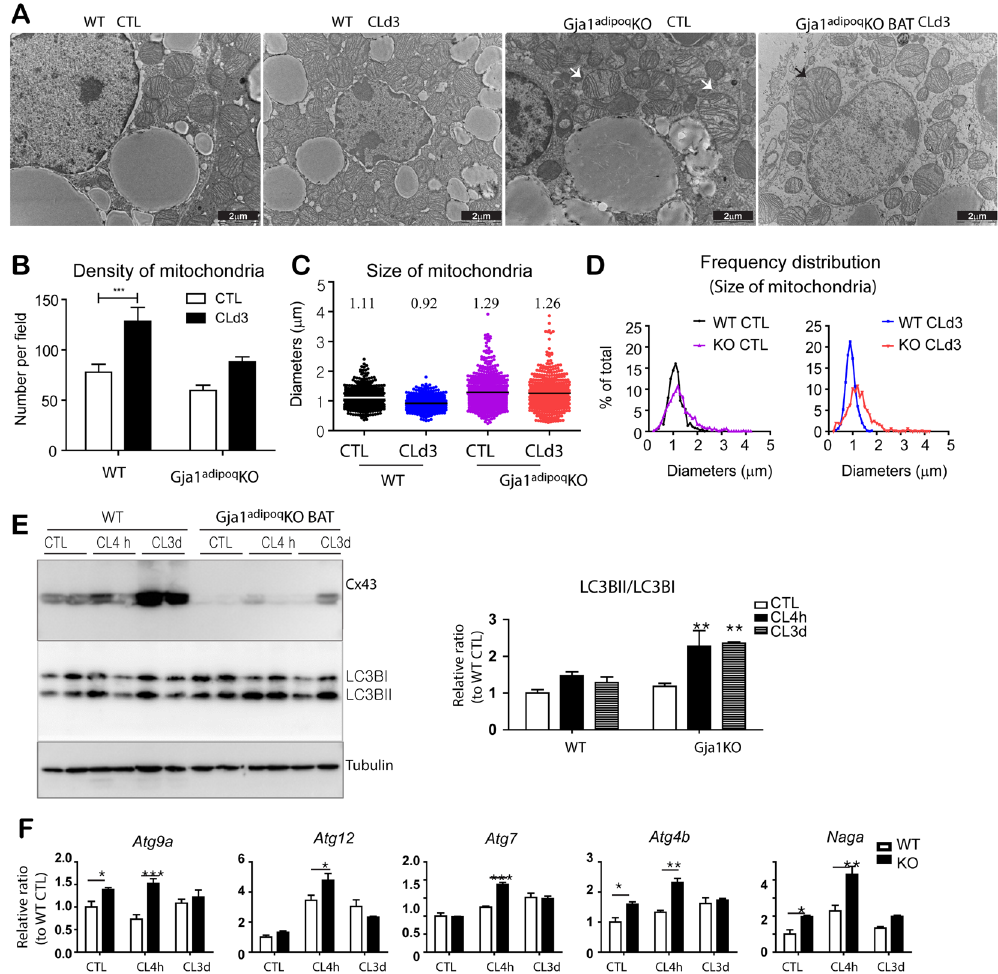
Figure 4. Adipose specific Gja1 KO generates abnormal mitochondria and increase autophagy in BAT. ( A ) Representative electron micrographs of BAT from WT and Gja1 adipoq KO mice treated with CL for 3 days and untreated controls. ( B ) Mitochondrion density in electron micrographs (mean ± SEM; n = 3 per condition). ( C ) Mitochondrion size in electron micrographs. Mean values were indicated above the scatter plots. ( D ) Distribution analysis of mitochondrion size. ( E ) Immunoblot analysis of LC3I/LC3BII ratio in BAT of Gja1 adipoq KO mice and WT controls treated with CL up to 3 days. Two-way ANOVA revealed significant main effects of Gja1 expression on LC3BII/LC3BI ratio (p = 0.0053).(mean ± SEM; n = 3 per condition). ( F ) qPCR analysis of autophagy markers in BAT of mice treated with CL for up to 3 days. Two-way ANOVA revealed significant main effects of Gja1 expression in mRNA levels ( Atg9a : p = 0.0001, Atg7 : p = 0.0041, Atg4b : p = 0.017, Naga : p = 0.0001). (mean ± SEM; n = 3 per condition, * p < 0.01, ** p < 0.05, *** p < 0.001). (Immunoblots accompanied by size markers in Fig.